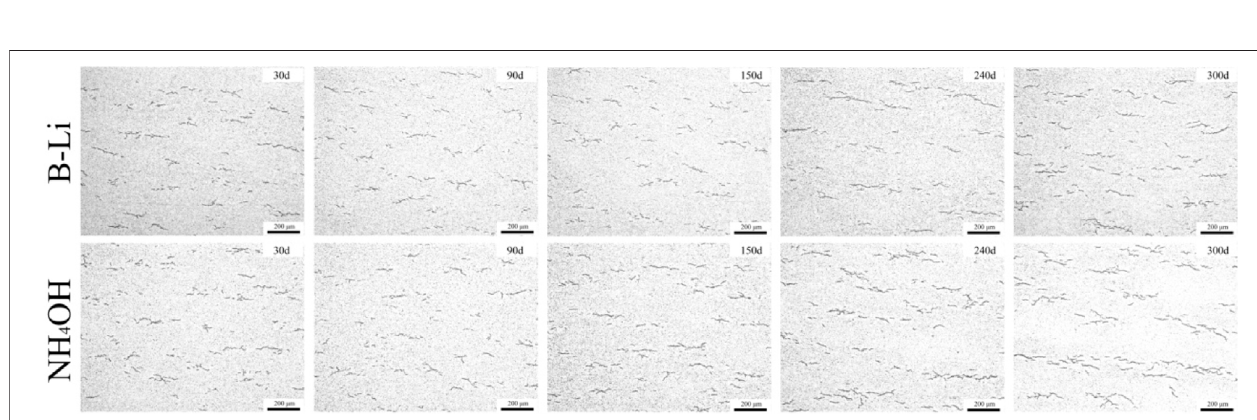
Frontiers in Materials |